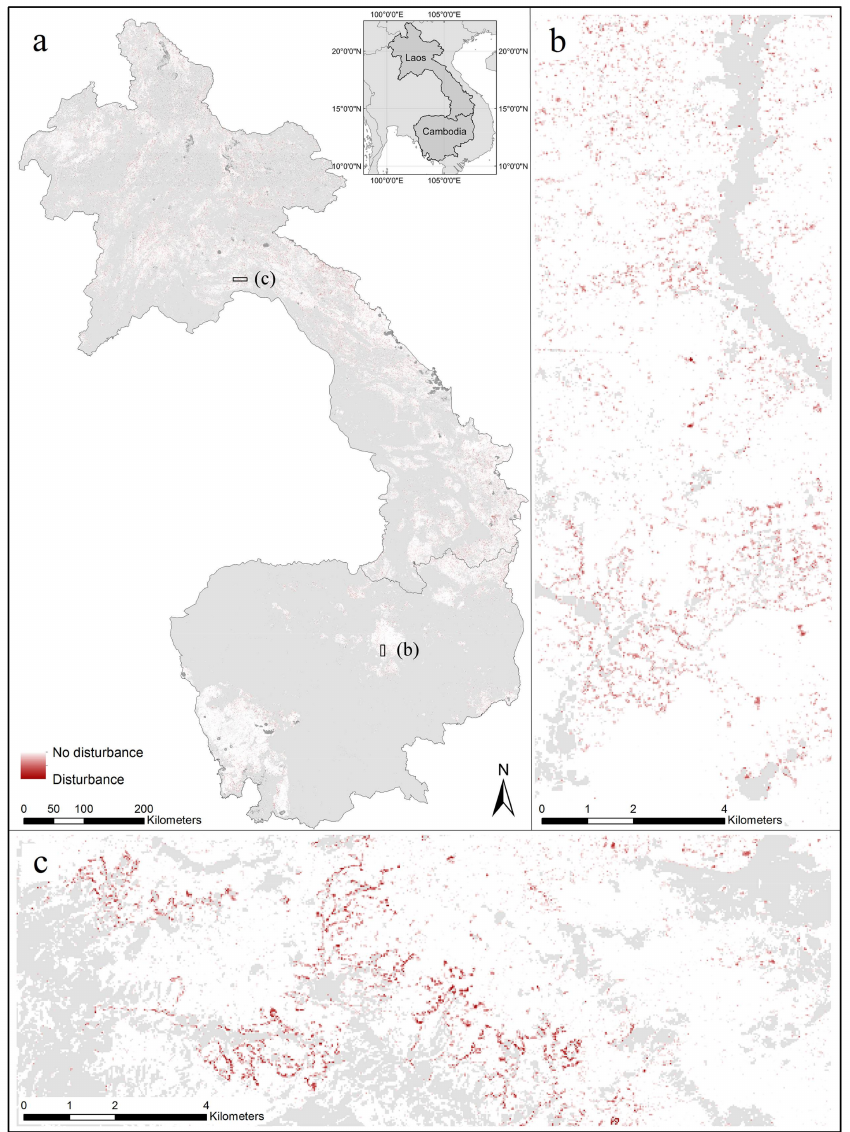
Figure 4. Aggregated ∆ rNBR results (maximum value of 2015 and 2016) for Laos and Cambodia. ( a ) Overview of countrywide map; evergreen forest (status end 2016) = white; possible disturbance events = reddish; other land cover types = light grey; missing data = dark grey; black rectangles = positions of subsets. ( b ) Subset of Kampong Thom province, Cambodia. ( c ) Subset of Vientiane and Bolikhamsai provinces,